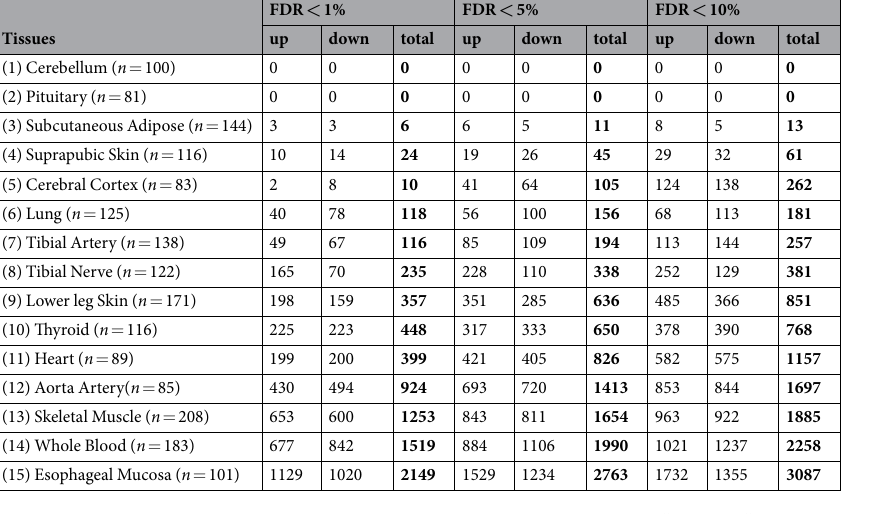
Table 1. Numbers of PMI-associated genes in 15 human tissues. Columns “up” and “down” list the number of positive correlation and negative correlation PMI-associated genes respectively. Results derived from using three different FDR cutoffs (1%, 5%, and 10%) are